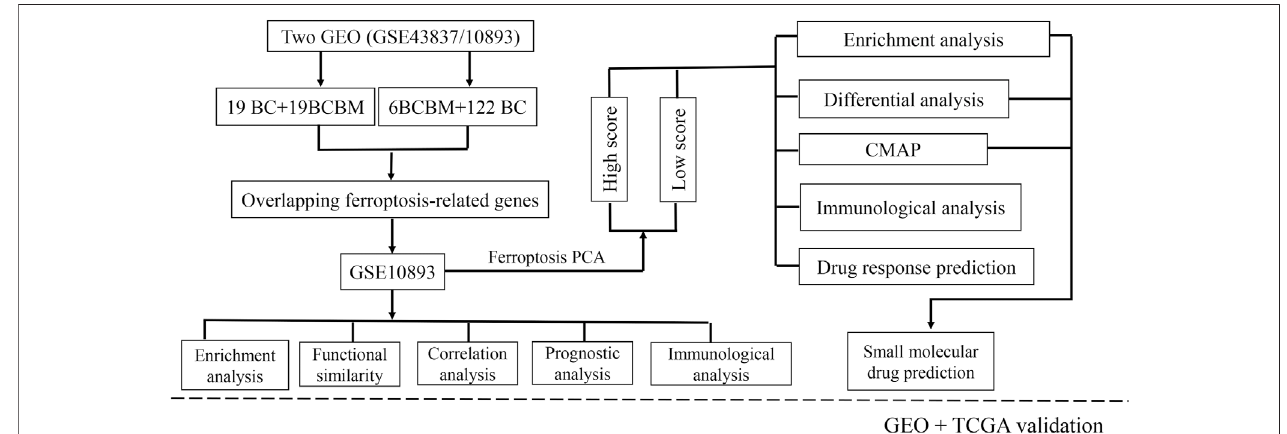
FIGURE 1 | Flowchart of the study design. BCBM: breast cancer brain metastasis; BC: breast cancer; GO: Gene Ontology; KEGG: Kyoto Encyclopedia of Genes and Genomes; PPI: protein-protein interaction; CMAP: Connectivity Map; GEO: Gene Expression Omnibus; TCGA: the Cancer Genome Atlas.